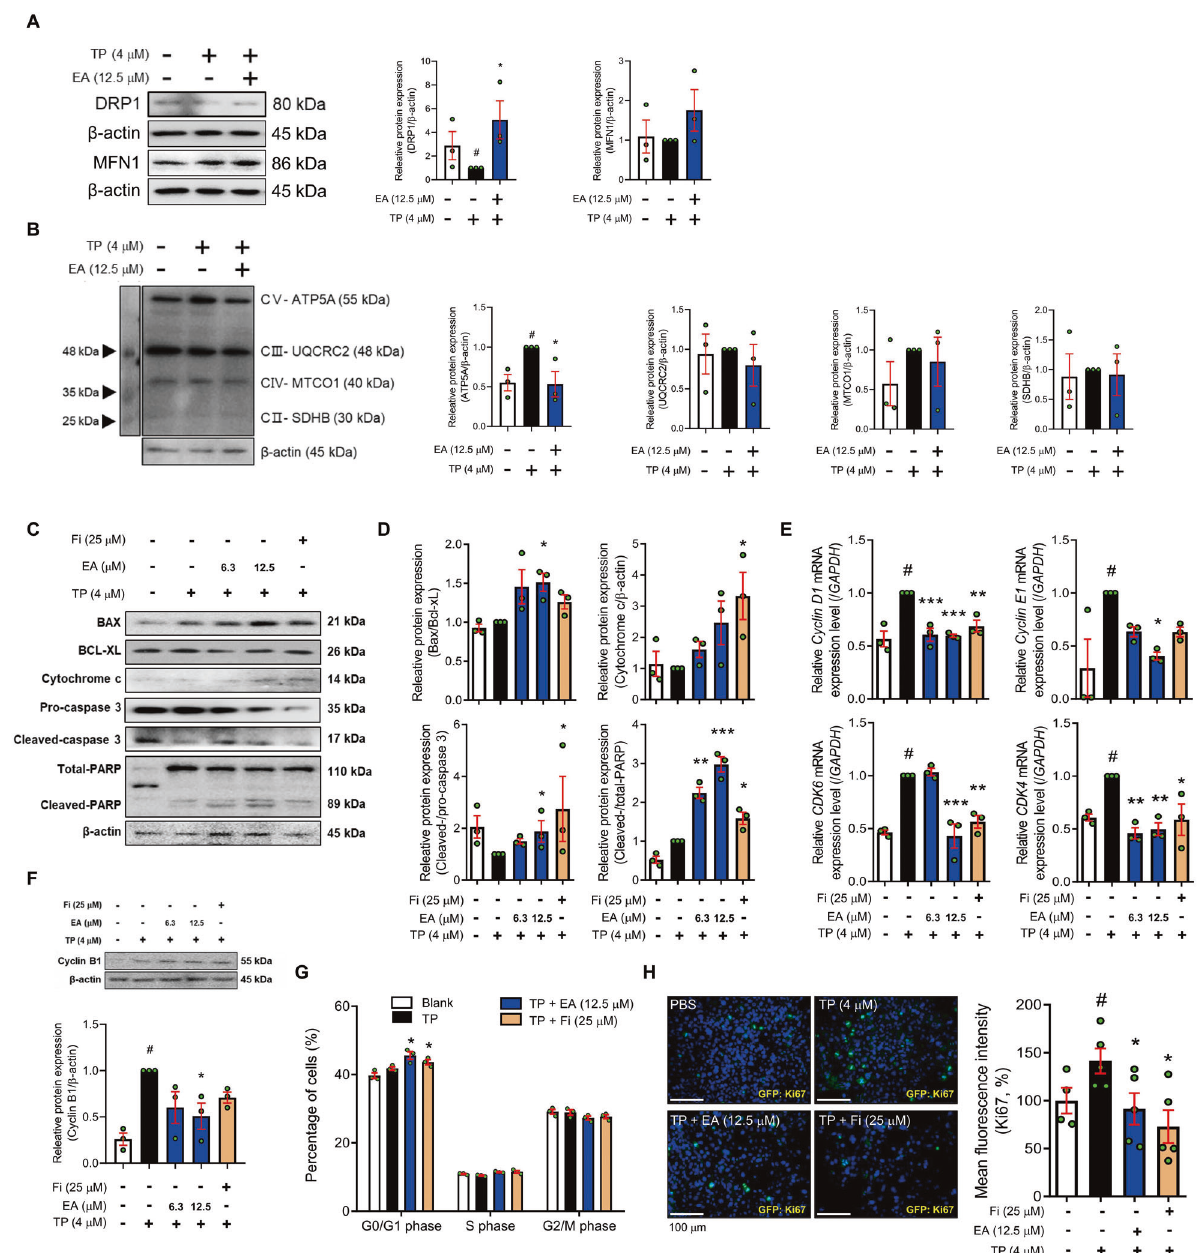
Fig. 4 EA induces mitochondria-mediated apoptosis in TP-treated RWPE-1 cells. A , B Protein levels of DRP1, MFN1, and OXPHOS were measured by Western blot analysis. C , D Protein levels of Bax, Bcl_xL, cytochrome c, pro-/cleaved-caspase 3, and total/cleaved-PARP were analyzed by Western blot analysis. E mRNA expressions of Cyclin D1, Cyclin E1, CDK4 , and CDK6 were measured by RT-PCR, and data were normalized to GAPDH . F Protein level of cyclin B1 was measured by Western blot analysis. G Population of cell cycle (G0/G1, S, and G2/M) was analyzed using fl ow cytometry. H Protein level of Ki67 was detected using immuno fl uorescence staining (magni fi cation 200×, scale bar 100 μ m). β -actin was used as a loading control. All data are expressed as the mean ± S.E.M. of data from three or more separate experiments. Statistical differences were calculated by one-way ANOVA with post-hoc Tukey ’ s test. # p < 0.05 vs. PBS-treated RWPE-1 cells, * p < 0.05 and ** p < 0.01 vs. TP-treated RWPE-1 cells. PBS phosphate-buffered saline, TP testosterone propionate, EA ellagic acid, Fi fi nasteride. through a combination with AR in androgen binding sites [18]. Stattic downregulates the AR expression in TP-treated RWPE- Molecules of a DHT/AR complex move into a nucleus and then 1 cells (Fig. 6F). bind to the ARE present in the promoters of target genes leading growth and survival of prostate epithelial cells [19]. Next, they trigger the proliferation of prostate cells by activation of cell cycle DISCUSSION progression and increase PSA expression levels in the cells [20]. During the process of BPH development, an imbalance between Increased expressions of AR, 5AR2, and PSA correlate with prostate testosterone and DHT is a major pathophysiological factor in hyperplasia, and these markers are increased markedly in patients prostate remodeling [17]. DHT initiates AR signaling pathways Cell Death and Disease (2022)